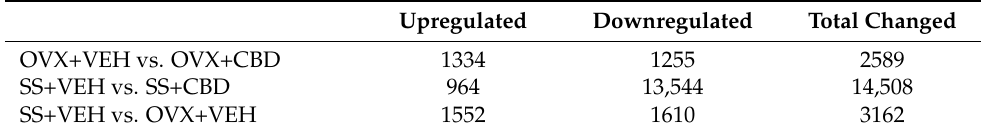
Table 1. Differentially Expressed Genes in Total